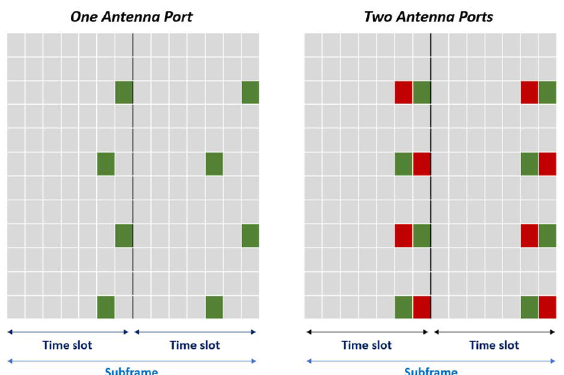
Figure 4. Allocation scheme of channels and signals in even frames (up) and odd frames (down) in guard-band and stand-alone mode [32].